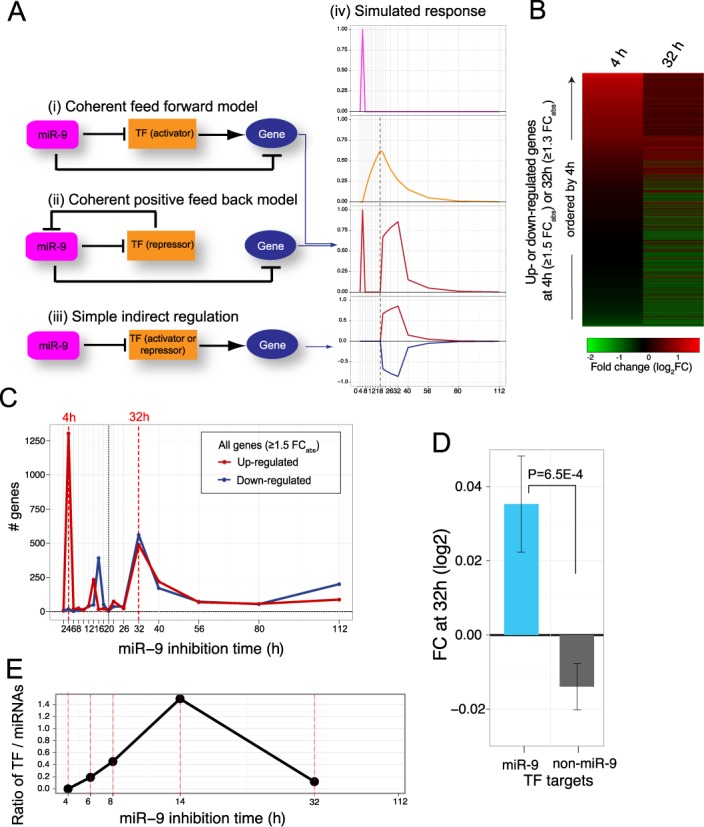
Evidence for downstream 32 h peak representing a coherent secondary response. (A) Coherent feed-forward and feed-back models. In the feed-forward model, (i), miR-9 directly targets a gene and also indirectly represses the same gene by targeting an (activator) transcription factor (TF) controlling that gene. In the positive feed-back model, (ii), miR-9 directly targets a gene and also indirectly represses the same gene by targeting a repressor TF that targets the miR-9 genes themselves. Such regulatory mechanisms can potentially amplify and sustain the miR-9 direct response. By contrast, (iii) shows simple downstream indirect regulation of a gene without feed–back or feed-forward regulation. (iv) shows simulated time series response of the various models. Top panel shows initial expression impulse response at 4 h due to LNA de-repression of miR-9; second panel from top shows increased TF (protein) levels due to miR-9 perturbation; third panel shows expression level of the target gene in coherent feed–forward or feed–back regulation, with a 4 h peak due to the direct miR-9 de-repression and a secondary peak commencing once the TF (gold) reaches an activation threshold (dotted line—0.6 in this case); the bottom panel shows the response for the simple indirect regulation of a non-miR-9 target downstream gene (red = activator TF, blue = repressor TF). x-axis = time in hours; y-axis = normalized protein or RNA levels. (B) Heatmap showing the distribution of genes with substantial FC response at 4 or at 32 h (absolute FC ≥ 1.5 at 4 h or ≥ 1.3 at 32 h), highlighting that substantial 4 h responses tend to be followed by upward responses at 32 h (red = induced; green = repressed; rows sorted by 4 h response). (C) Number of up and downregulated genes with absolute FC ≥1.5 in antimiR-9 treated cells at each time point. The peak at 4 h is asymmetric, with predominantly upregulated genes; the peak at 32 h is symmetric, with a mix of up and downregulated genes, consistent with a TF-driven secondary response at this time. (D) Comparison of downstream FC response at 32 h of TF target genes regulated by TFs predicted to be directly targeted by miR-9 (blue) compared with FC response of targets of TFs predicted not to be miR-9 direct targets (grey), The large positive response for TFs targeted by miR-9 is consistent with coherent feed–forward regulation (analysis based on genes showing substantial response, ≥1.5 absolute FC, at any time point; error bars show SE). (E) The ratio of number of highly significantly enriched (P < 1E-4; GSEA) transcription factor motifs to miRNA seeds across time. Four hours shows significantly enriched miRNA seed motifs but no significant TF motifs; 14 h shows substantial enrichment of TF motifs relative to miRNA seeds; 32 h shows substantial enrichment of both (time points showing no significant miRNA or TF motif enrichment not shown).